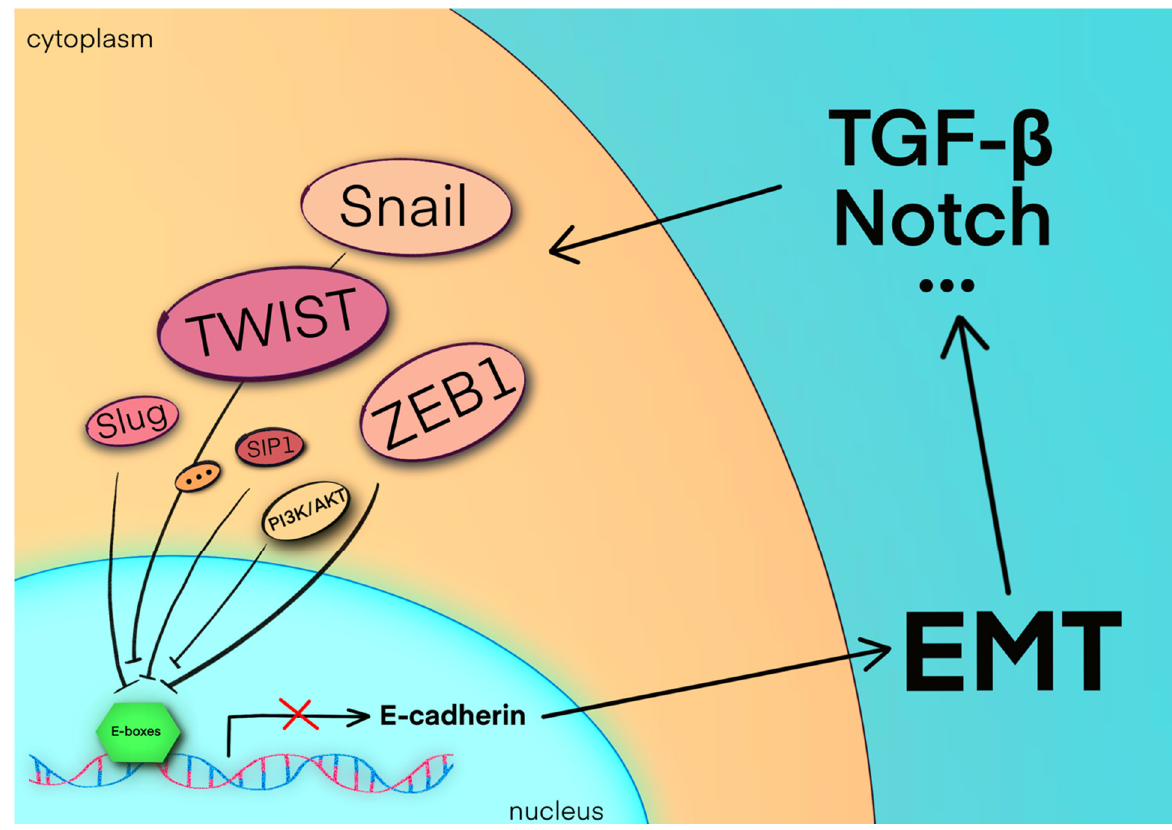
Figure 1. Binding of EMT-AFTs, such as Snail, TWIST, and ZEB1, to E-boxes in the promoter suppresses E-cadherin gene expression, which is the hallmark of EMT. The cells then acquire mesenchymal features and migration capability, and even the stem-cell-like features of the so-called cancer stem cells (CSCs). Moreover, several complex signaling pathways, such as the PI3K/AKT pathway, TGF- β pathway, Notch pathway, etc., participate in regulating the expression of EMT-AFTs, forming a feedforward loop that promotes the EMT process